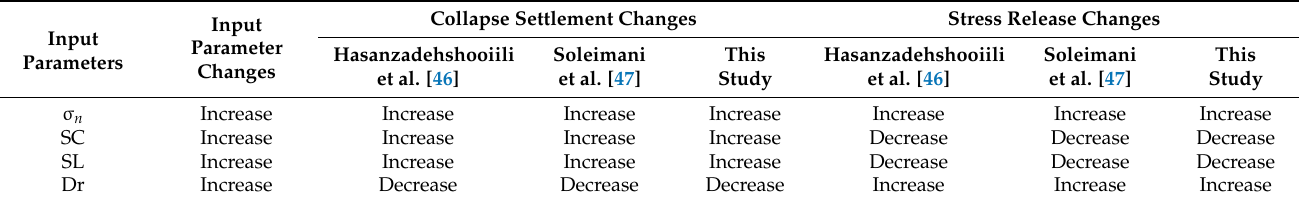
Table 12. Comparing the influence of input parameter changes on collapse settlement and coefficient of stress